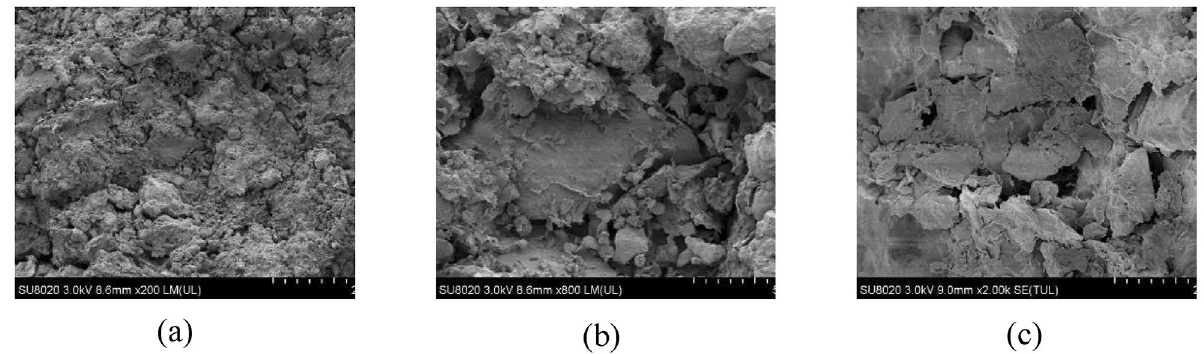
Figure 14. Scanning electron microscope image of liquefied soil at increasing magnification: ( a ) 200×, ( b ) 800×, and ( c )